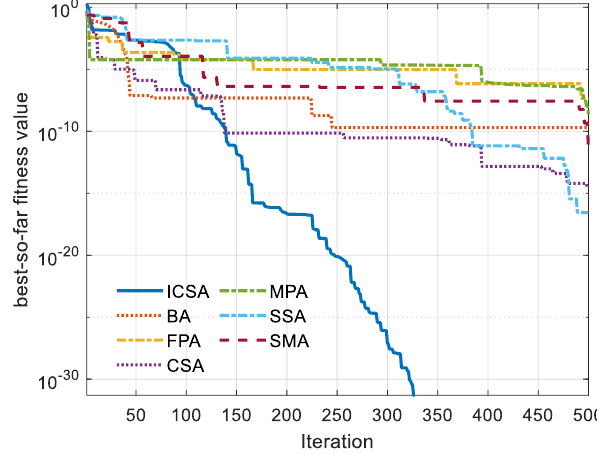
Figure 20. Convergence curve for F20.